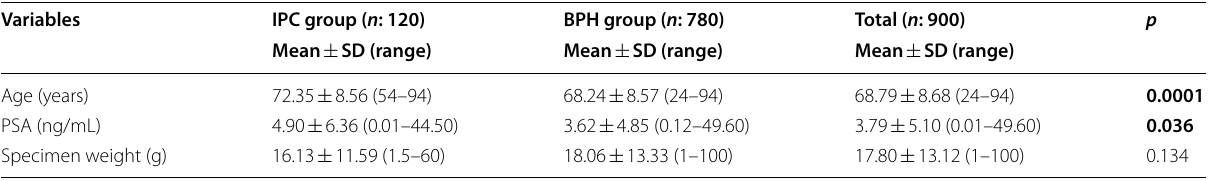
IPC incidental prostate cancer, BPH benign prostatic hyperplasia, PSA prostate-specific antigen, SD standard deviation Bold values indicate statistical significance at the p < 0.05 level